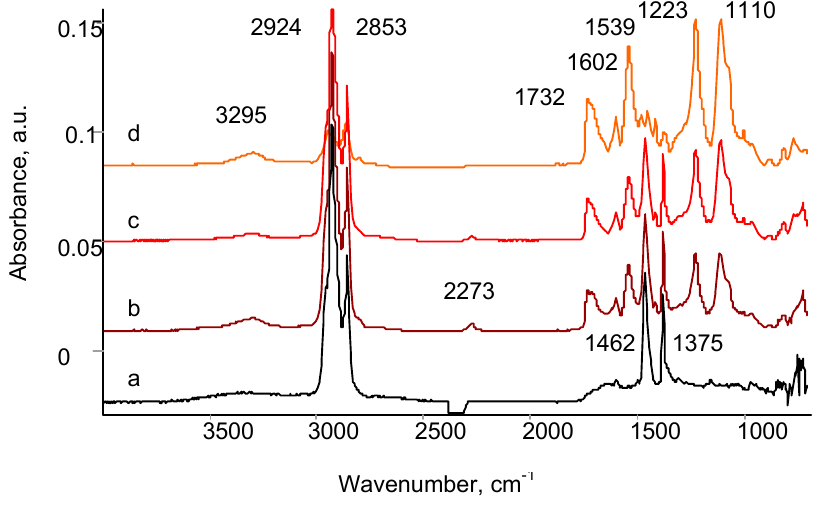
Figure 9. FTIR ATR spectra of peeled of adhesion joint: ( a ) initial PIII treated EPDM rubber; ( b ) PIII treated EPDM rubber peeled off from PU; ( c ) PU peeled off from PIII treated EPDM rubber; ( d ) initial PU surface.